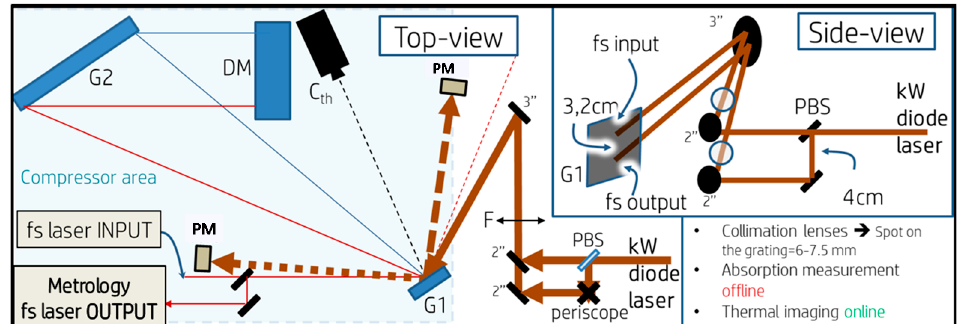
Figure 9. Top-view and side-view of the experimental set-up. Compressor Area: PM = power meter; C th = Thermal camera; G1 = first compressor grating; G2 = second compressor grating (gold, 56°, 1480l/mm); DM = Dihedral Mirror. Diode Area: F = imaging lens; PBS = Polarizing Beam Splitter.